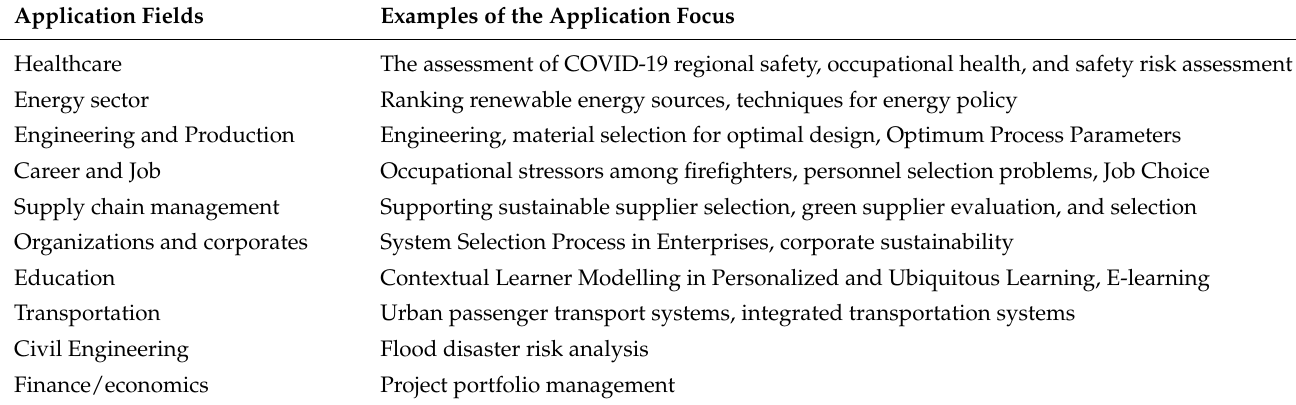
Table 1. Applications of MCDM